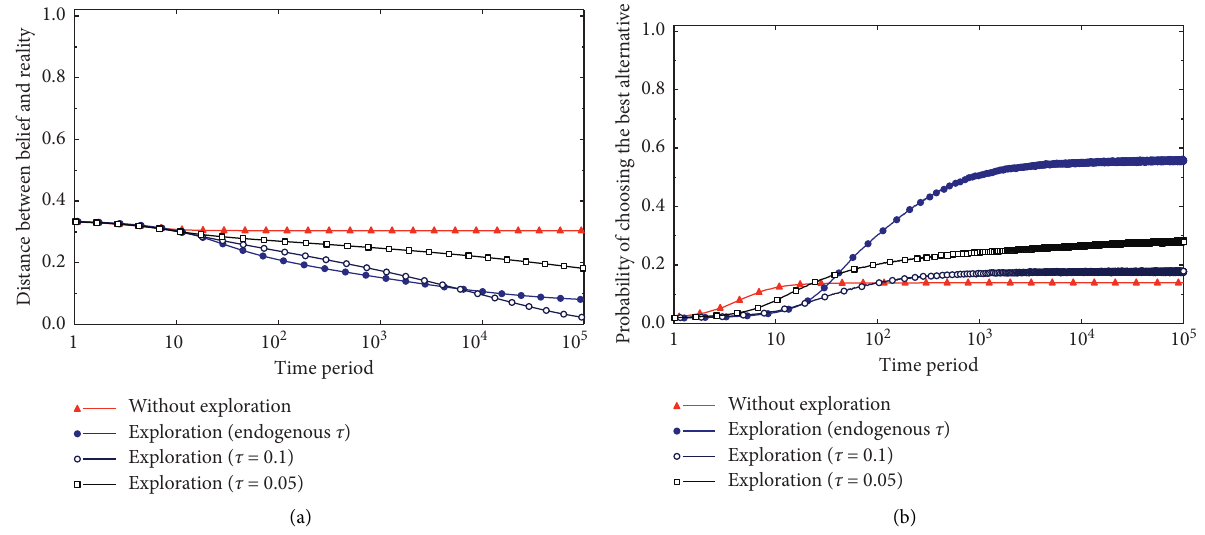
Figure 7: (a) Degree of biased beliefs (i.e., the distance between belief and reality); (b) probability of choosing the optimal alternative (note that when the high degree of exploration is exogenously given (e.g., τ � 0 . 1), the agent may choose suboptimal alternatives not because of SCBB but because of exploration (i.e., noise in the choice process)).